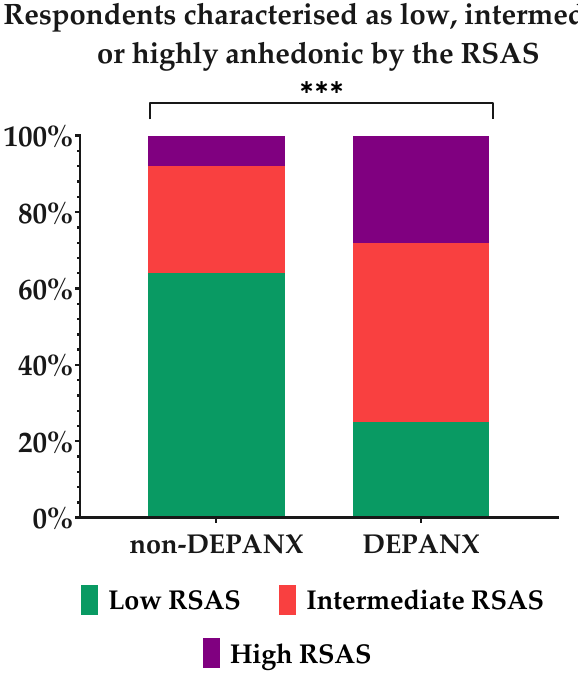
Figure 2. Social anhedonia levels in each group by measure of the Revised Social Anhedonia Scale. Results are shown for the two groups, ‘non-DEPANX’ ( n = 702) and ‘DEPANX’ ( n = 349). Asterisks indicate level of significance of p -values. ***: p < 0.001.